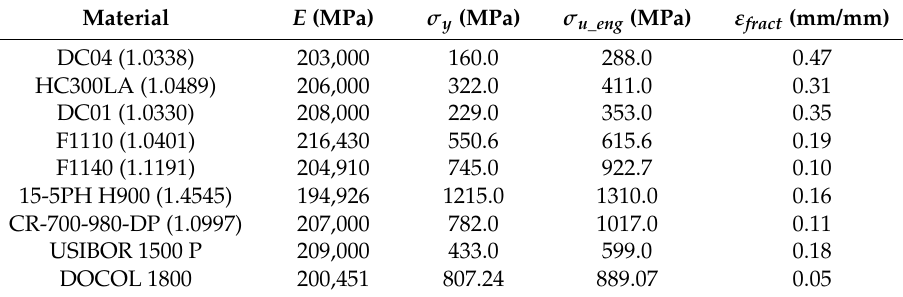
Table 2. Mechanical properties of the experimental